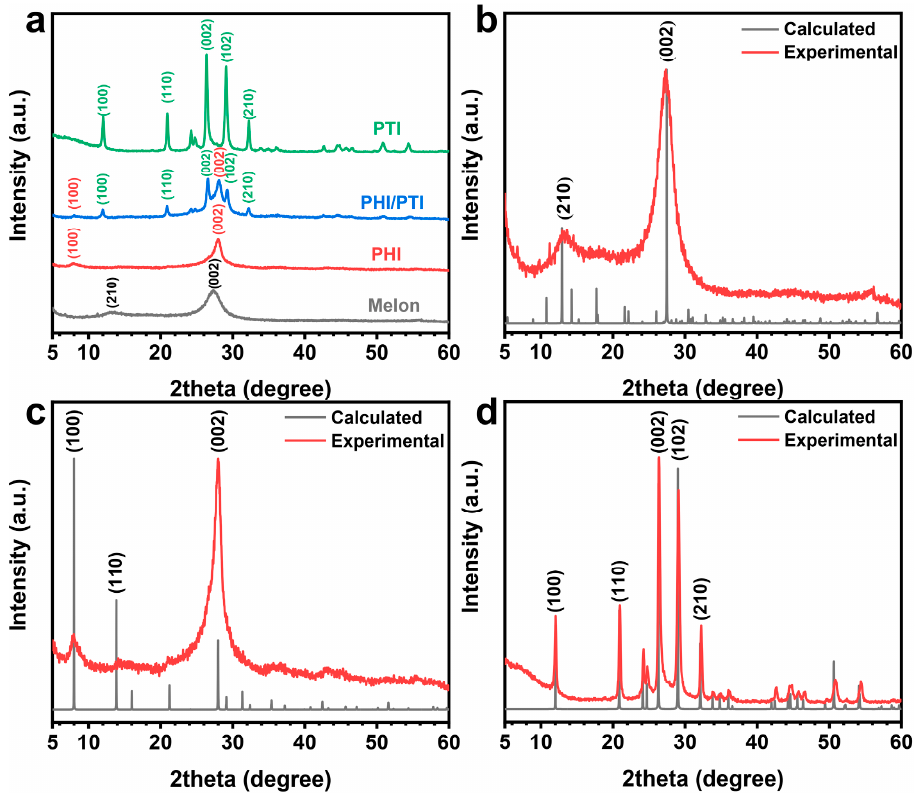
Figure 2. Crystal structure characterization of the g-C 3 N 4 samples. ( a ): Powder XRD patterns of melon, PHI, PHI/PTI and PTI samples. ( b – d ): Comparison of the calculated and experimental XRD data of melon, PHI and PTI.